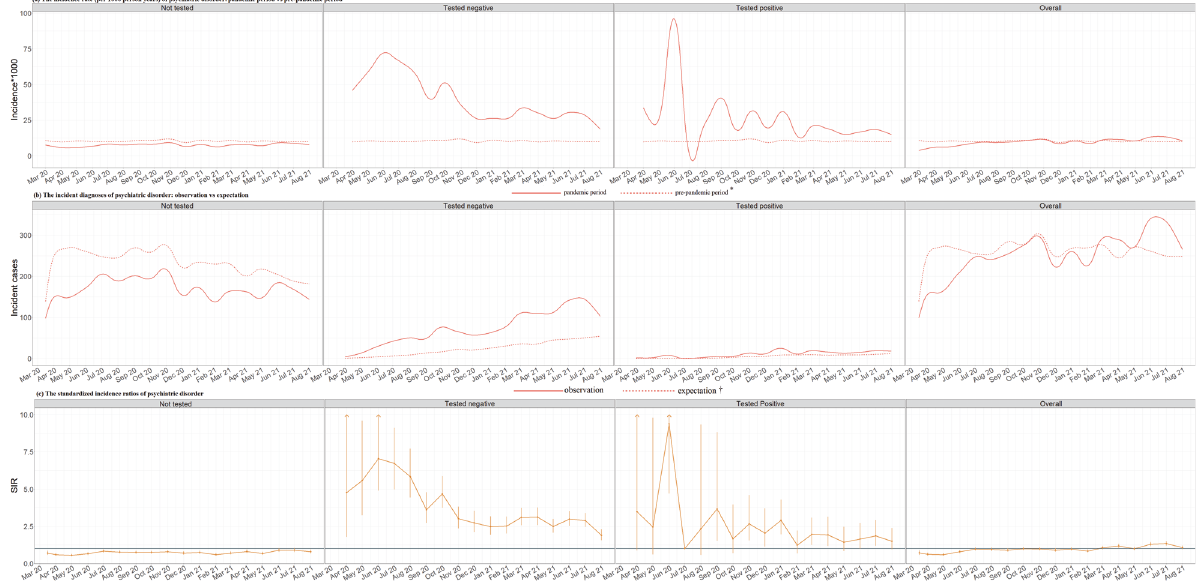
Fig. 2 Period speci fi c incident diagnoses of anxiety and depression disorder. Note, IR incidence rate, SIR standardized incidence ratio. * Three preceding years as the pre-pandemic period (i.e., from 1 January 2017 to 31 December 2019). † The expectation was calculated by multiplying the number of persons by the average month-speci fi c, sex-speci fi c, and age-speci fi c (1-year strata) incidence rate derived from pre-pandemic period. ‡ The standardized incidence ratio was calculated by comparing the number of observed incident cases with the